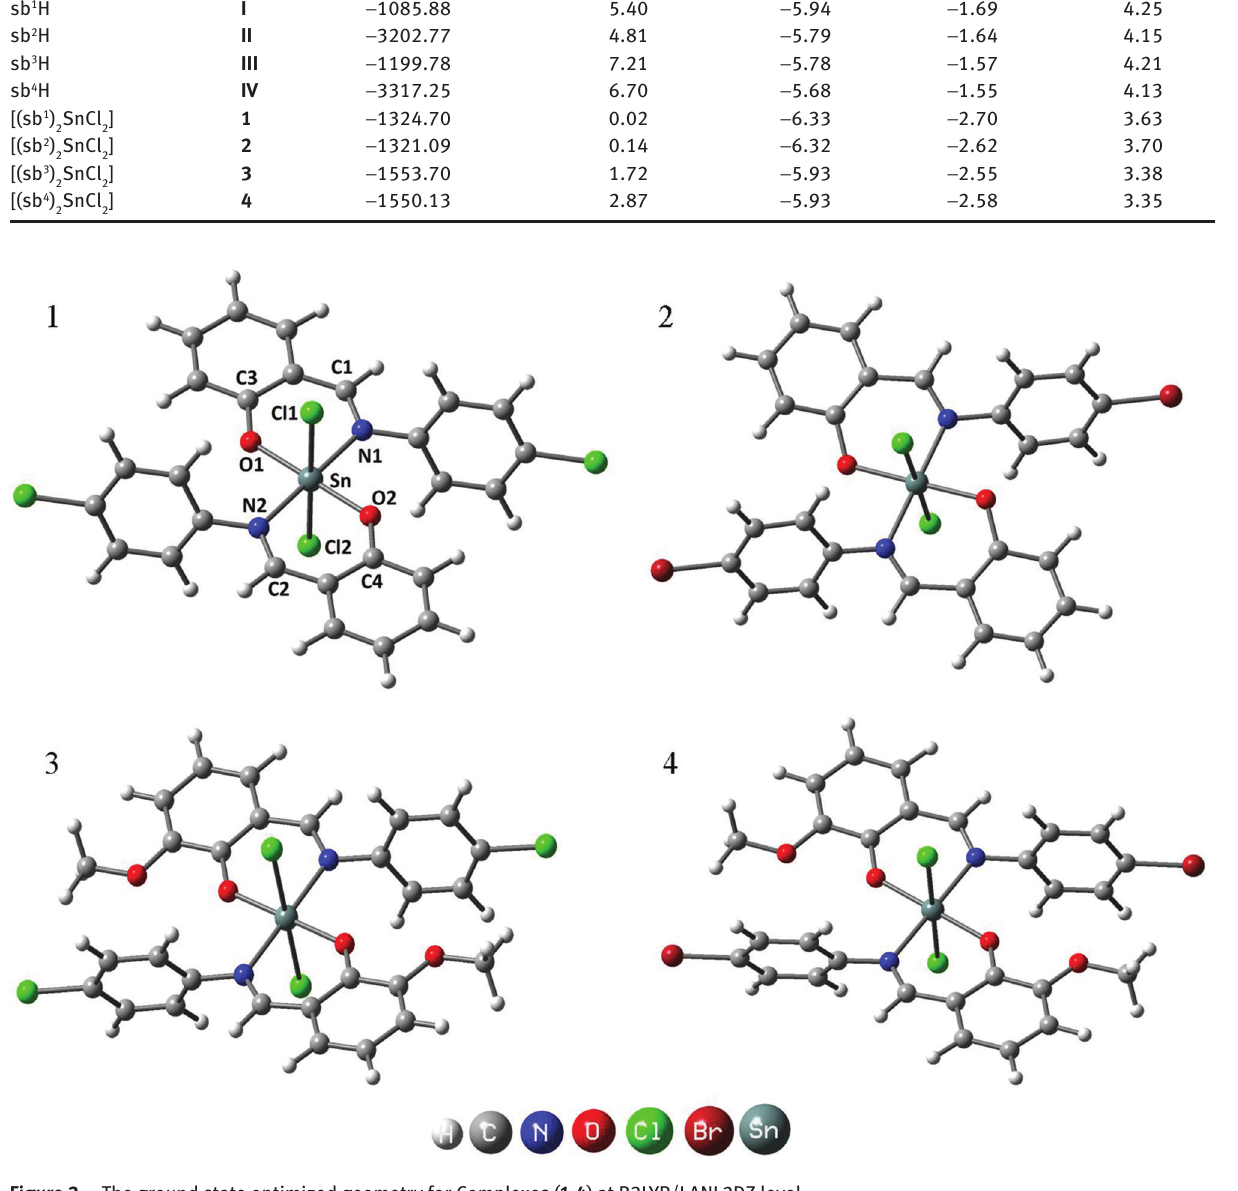
Figure 2: The ground state optimized geometry for Complexes ( 1-4 ) at B3LYP/LANL2DZ